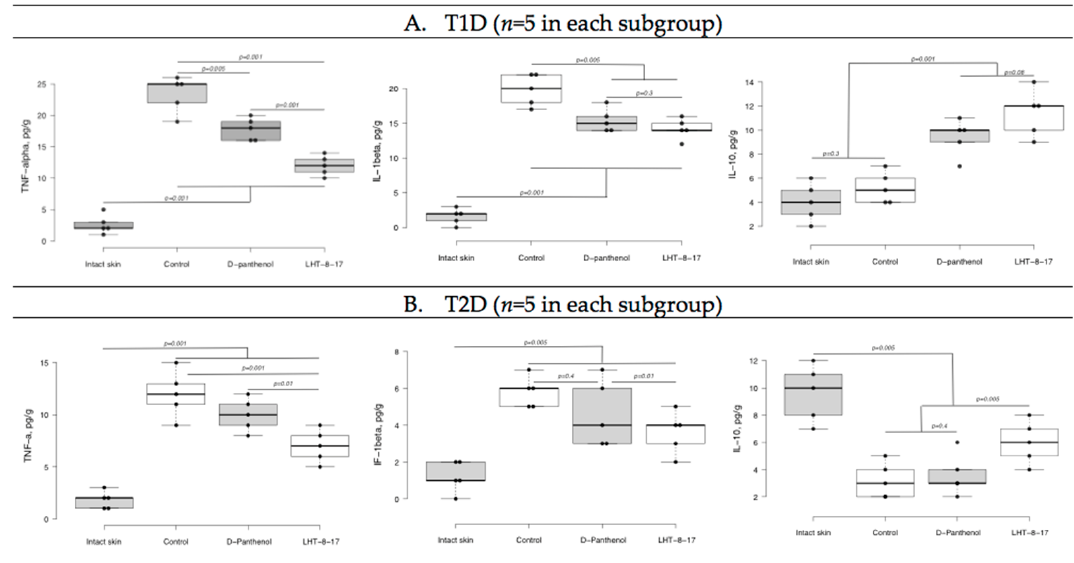
Figure 6. TNF- α , IL-1 β , and IL-10 tissue levels on day 5 of wound reparation under topical treatment with LHT-8-17 and the reference medication. Significance of differences was estimated using ANOVA and the Tukey criterion. ( A ) animals with type 1 of DM; ( B ) animals with type 2 of DM